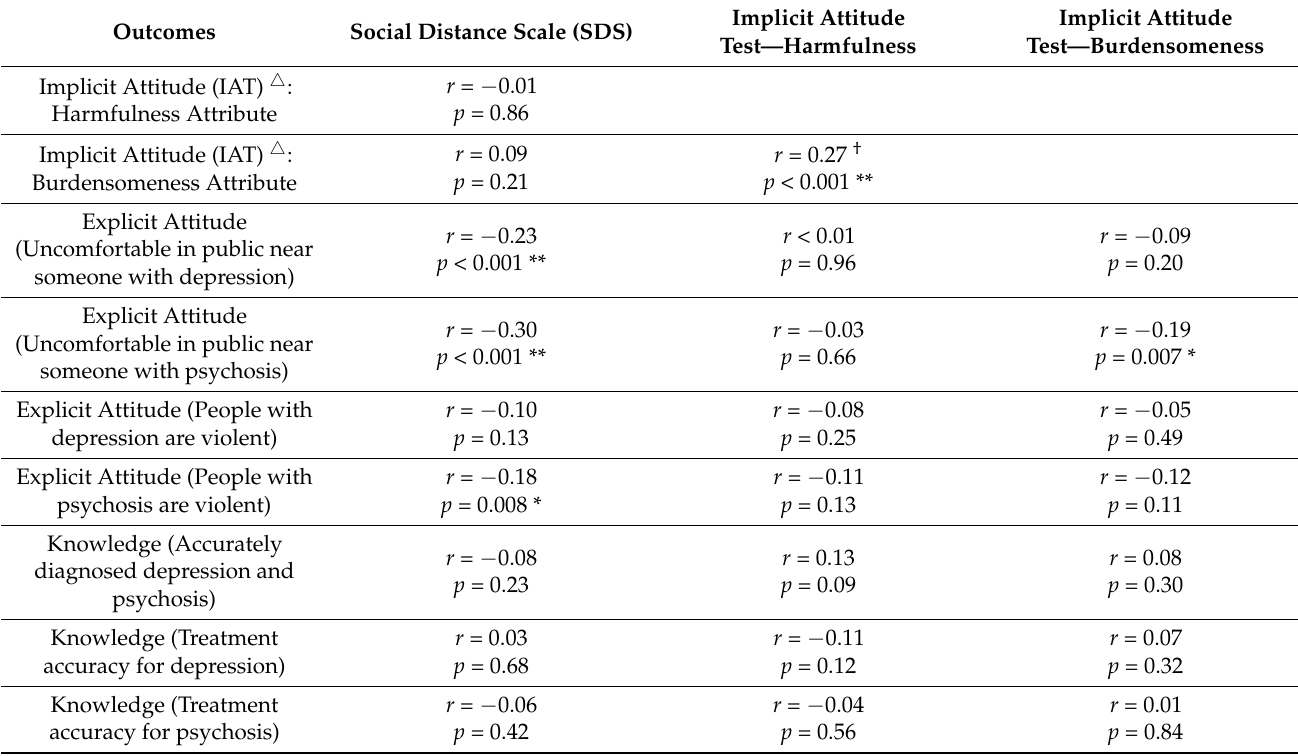
Table 6. Associations between explicit and implicit attitudes towards mental illness and knowledge to diagnose and treat depression and psychosis ( n = 213). Outcomes Social Distance Scale (SDS)